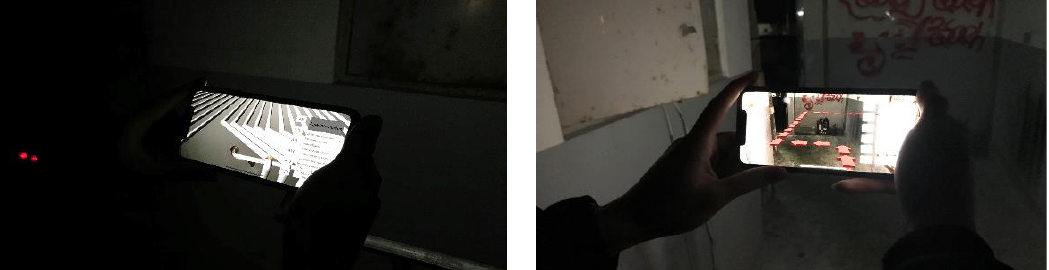
Figure 6. BARMS tested by a student in darkness.